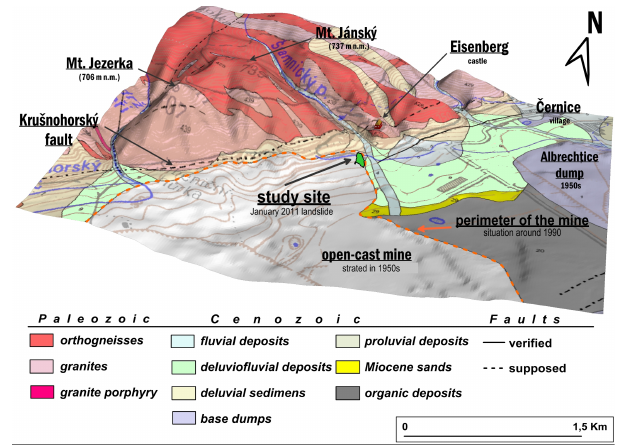
Fig. 2. General topographic and geological